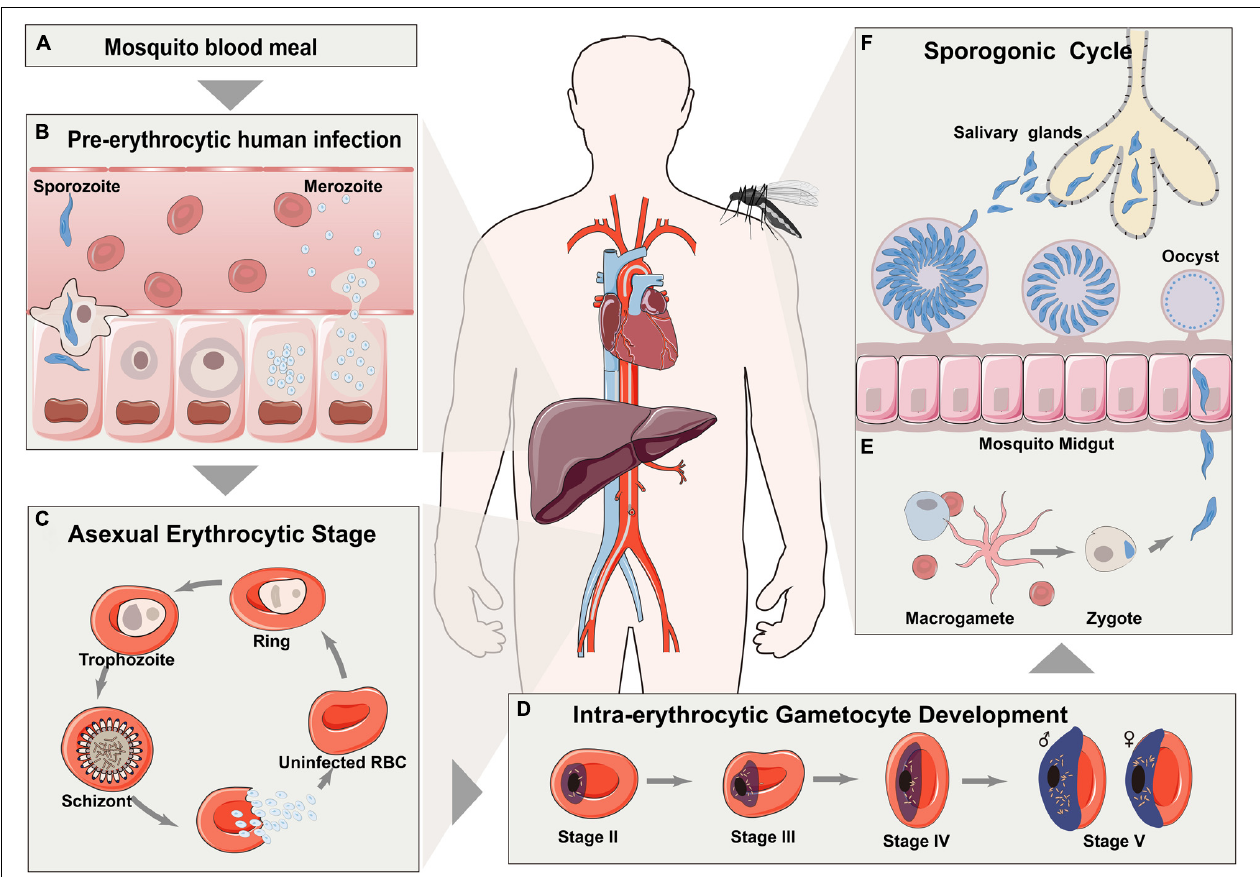
FIGURE 1 | Life cycle of representative plasmodium ( P. falciparum ). (A) Malaria is initiated through the bite of Anopheles mosquitoes. (B) Injected sporozoites are transported to liver through vasculature and then matured in hepatocytes. (C) After schizogony by producing hundreds of daughter merozoites, released merozoites then invade into erythrocytes for asexual life cycles. (D) A portion of asexually reproducing merozoites undergo reprogramming sexual differentiation to form gametocytes. (E) Matured gametocytes are then released into peripheral circulation for ingestion by a mosquito. (F) Formed zygotes transform into ookinete in the midgut of mosquito.